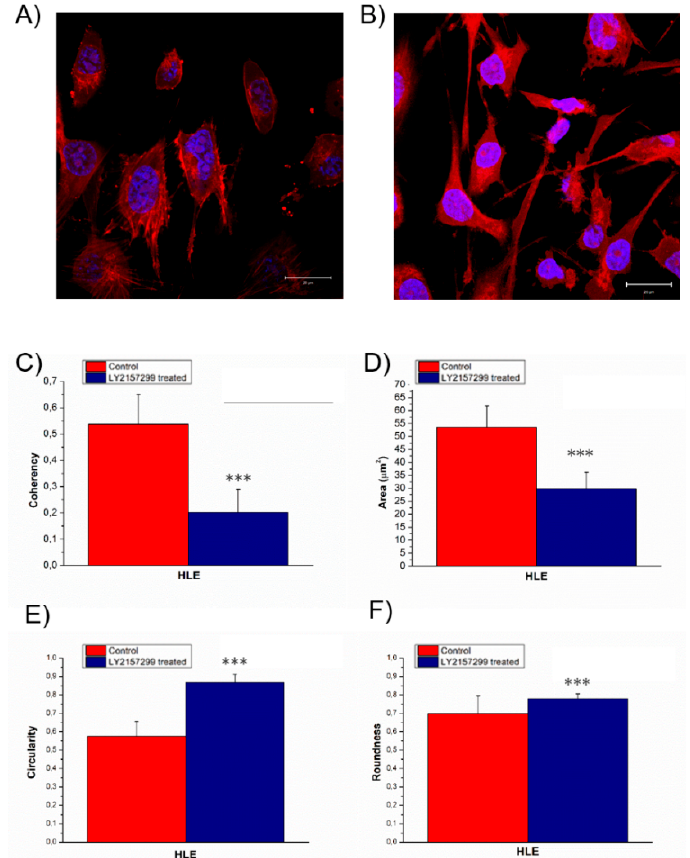
Figure 5. Representative confocal images of HLE CTR ( A ) and Galunisertib HLE LY2157299 treated for 48 h ( B ), the scale bar in the figures correspond to 20 µm. In the panel the value of F-actin coherency ( C ), nuclear area ( D ), circularity ( E ) and roundness ( F ) were reported. Analysis of F-actin and nuclear morphology of control and Galunisertib treated HLE cells, by using ImageJ software. Results were statistically significant for p < 0.005 (indicated as ***).